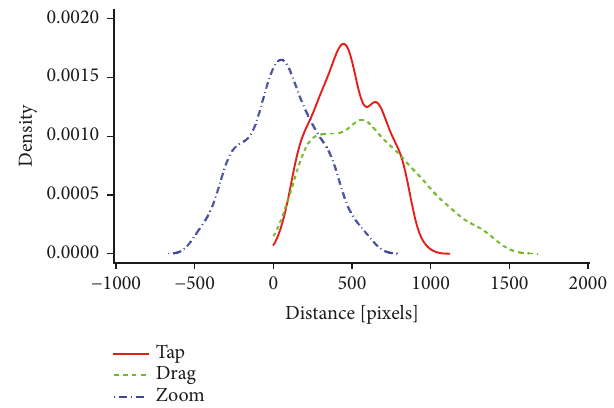
Figure 9: Density distribution of the major variable component for each of the three task types.